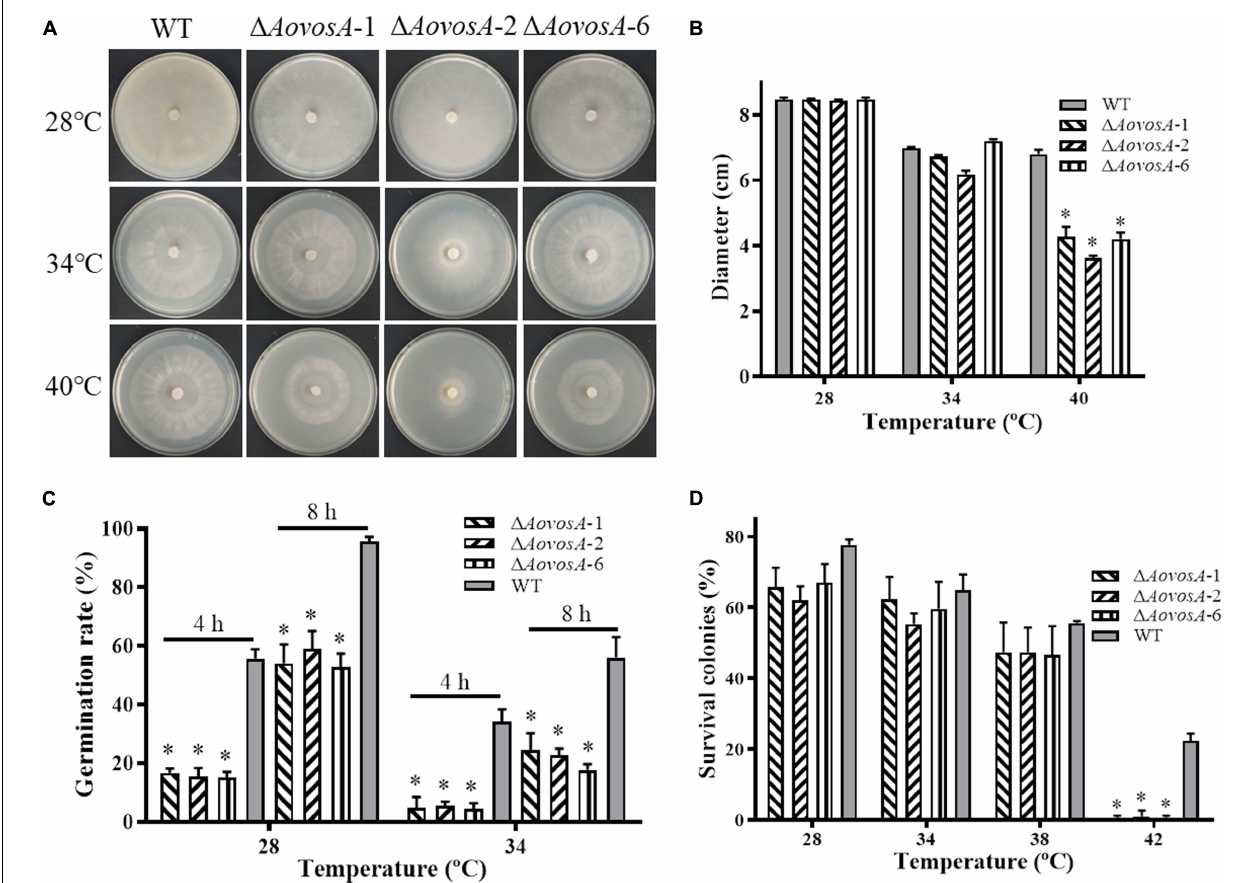
FIGURE 4 | Effect of AoVosA on heat shock stress in A. oligospora . (A) Colonies from the WT strain and (cid:49) AovosA mutants were incubated on PDA for 5 days at 28, 34, and 40 ◦ C. (B) Mycelial growth rates of the WT and (cid:49) AovosA mutants on PDA at the three temperatures. (C) Conidia germination rates for the WT strain and (cid:49) AovosA mutants at 28 and 34 ◦ C. (D) Spore survival rate of the WT strain and (cid:49) AovosA mutants treated by heat shock at 28, 34, 38, and 42 ◦ C. An asterisk indicates a significant difference between the mutants and the WT strain ( p <